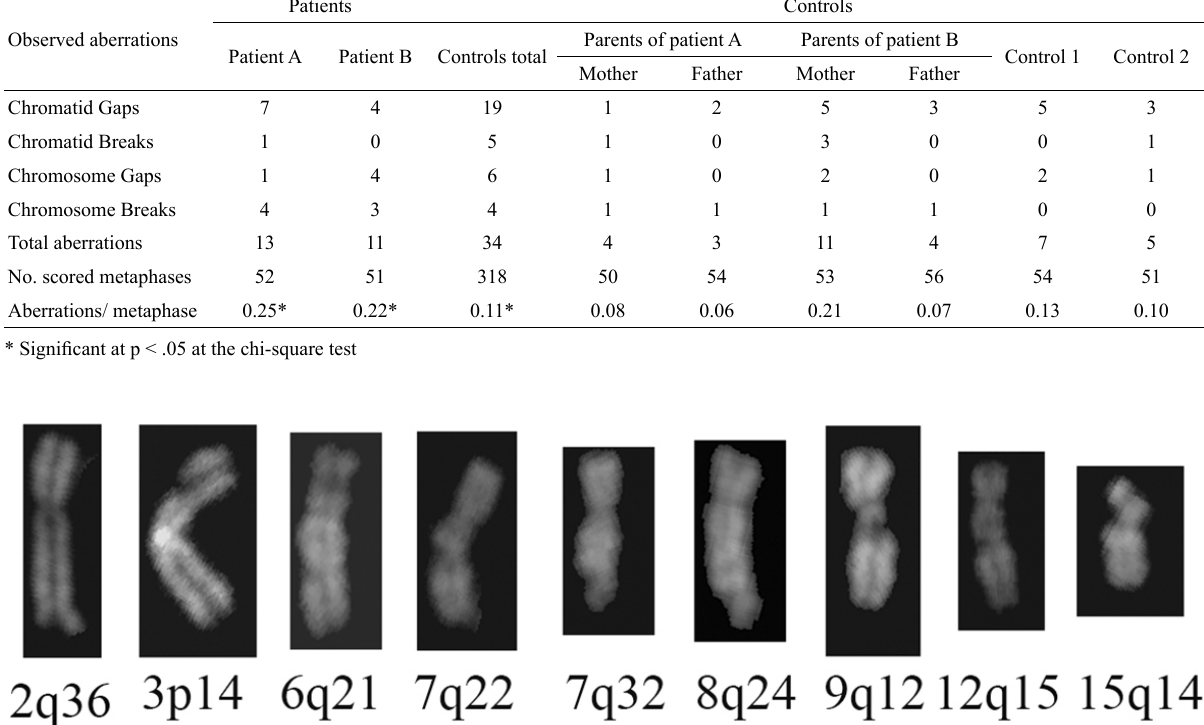
Figure 1 – Spontaneous breaks and gaps in two unrelated Italian patients with a clinical presentation reminiscent of Rothmund-Thomson syndrome. Selected representative images document the spontaneous breaks and gaps observed in the QFQ-banded chromosome spreads from blood samples of the two patients herein